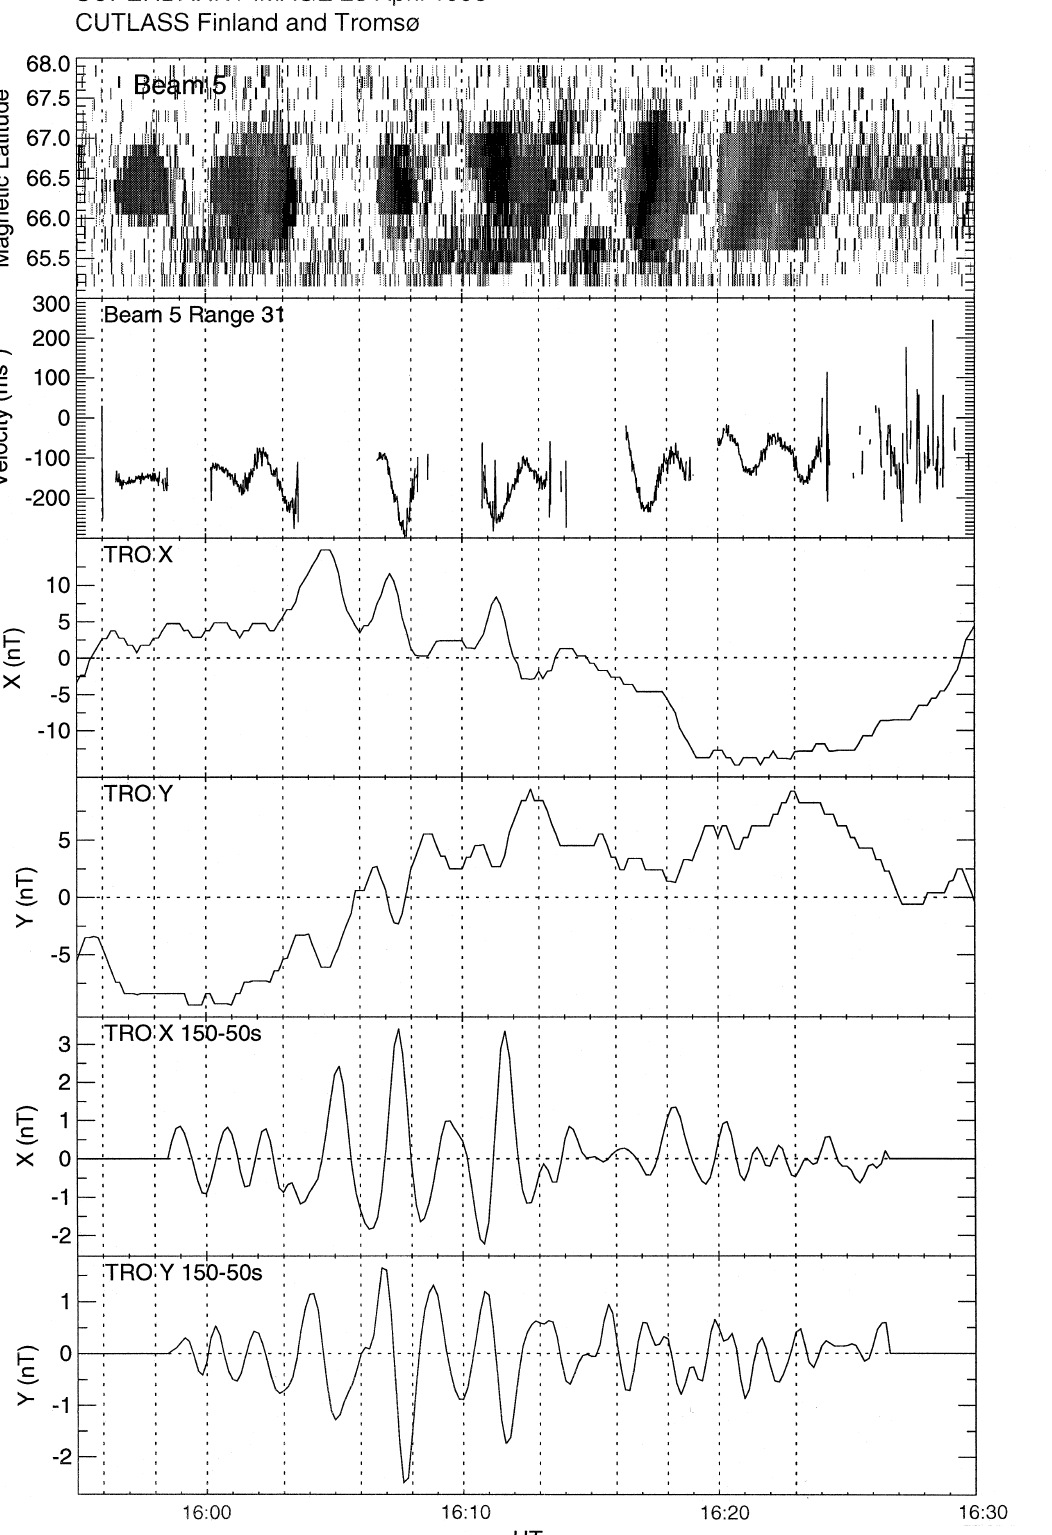
Fig. 2. An overview of the radar and magnetometer data during the interval. A greyscale representation of the Finland line-of-sight velocity data is given in the top panel (positive velocities are towards the radar). Patches of radar backscatter are observed during periods when the Tromsø ionospheric heater is operational (marked with vertical dashed